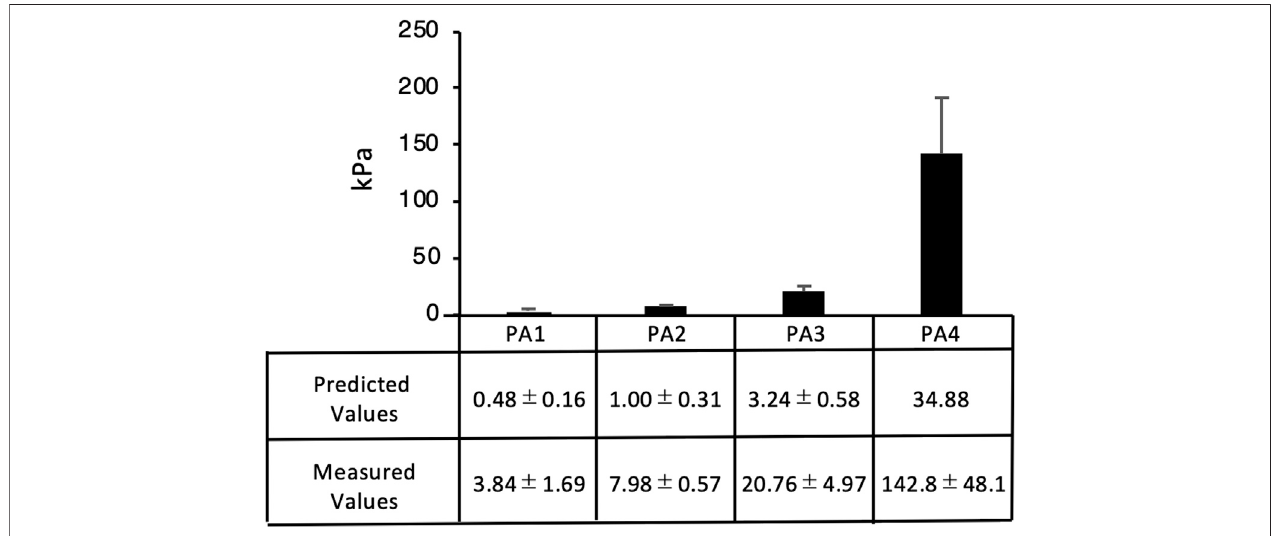
FIGURE3| Elasticmoduli ofPAgels.Average elastic modulusvalues weremeasured byAFM.The elastic modulusofthefour gels (PA1-4)was3.84, 7.98, 20.76, and 142.8 kPa, respectively. Each value represents the mean of three independent replicates ± the SD.